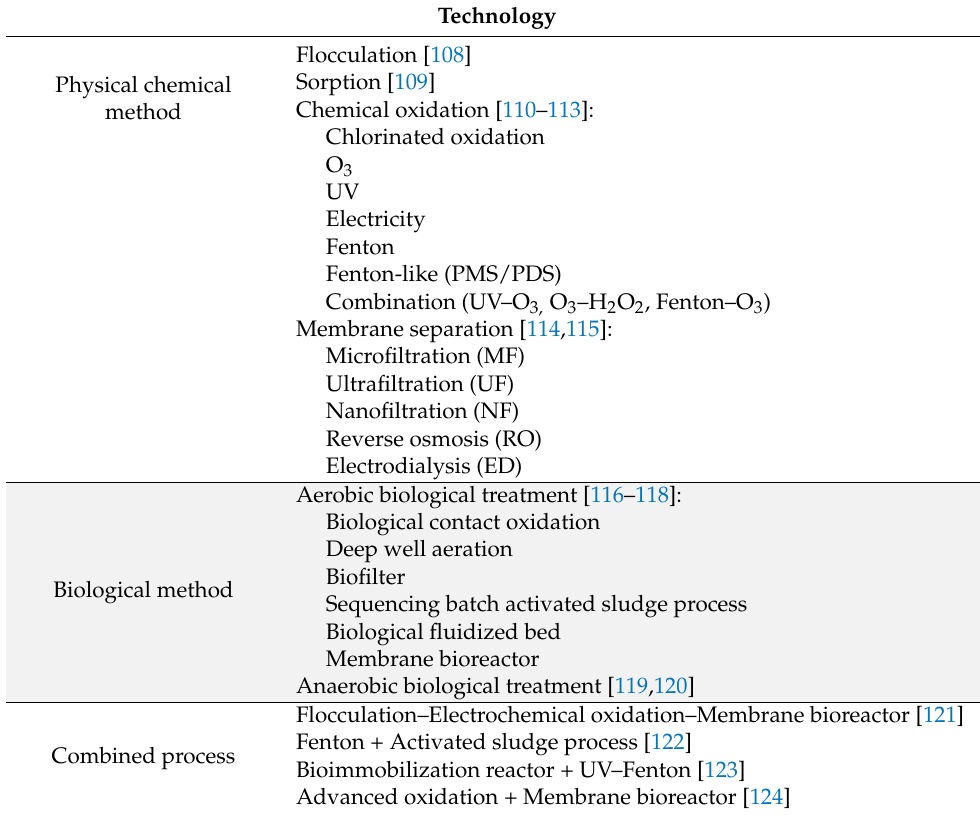
Table 6. Common methods for antibiotics